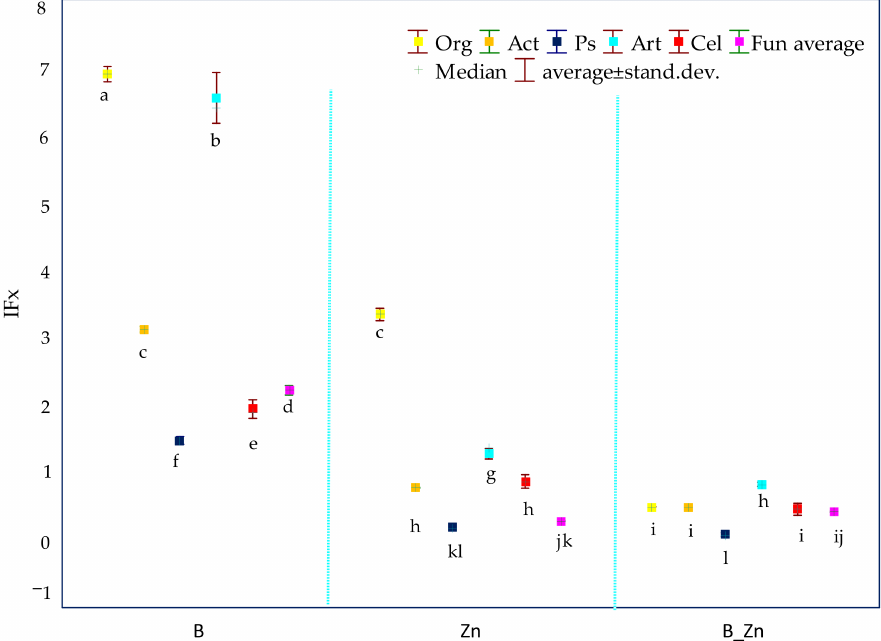
Figure 5. Reaction of soil microorganisms to unsown soil contaminated with B, Zn 2+ and B + Zn 2+ on the basis of the xenobiotic influence coefficient (IF X ); organotrophic bacteria (Org), actino- mycetes (Act), fungi (Fun), Pseudomonas sp. (Ps), Arthrobacter sp. (Art), cellulolytic bacteria (Cel); B—bisphenol A; Zn—zinc ion (Zn 2+ ). Homogeneous groups denoted with letters (a–l) were calculated for all